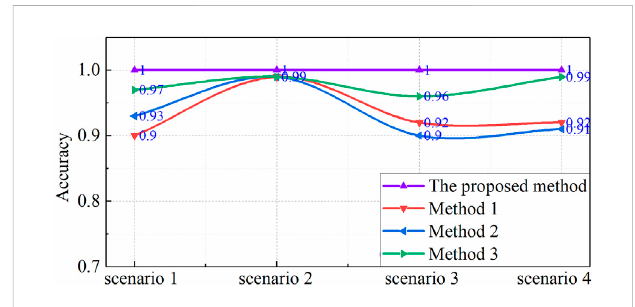
FIGURE 8 Accuracy of four islanding detection methods in four scenarios.